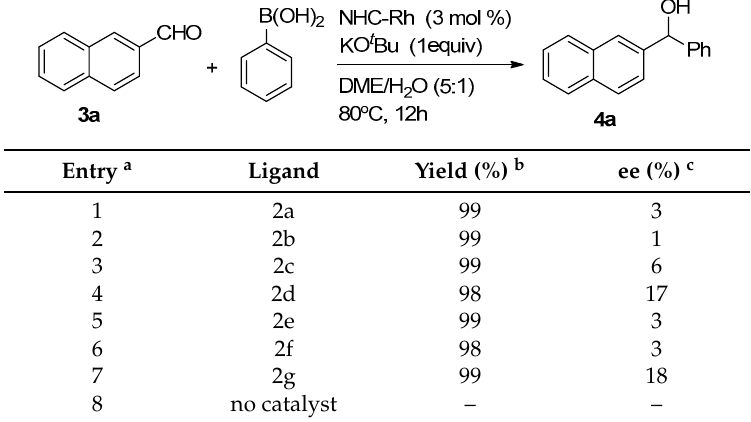
Table 1. Comparison of NHC–Rh complexes.